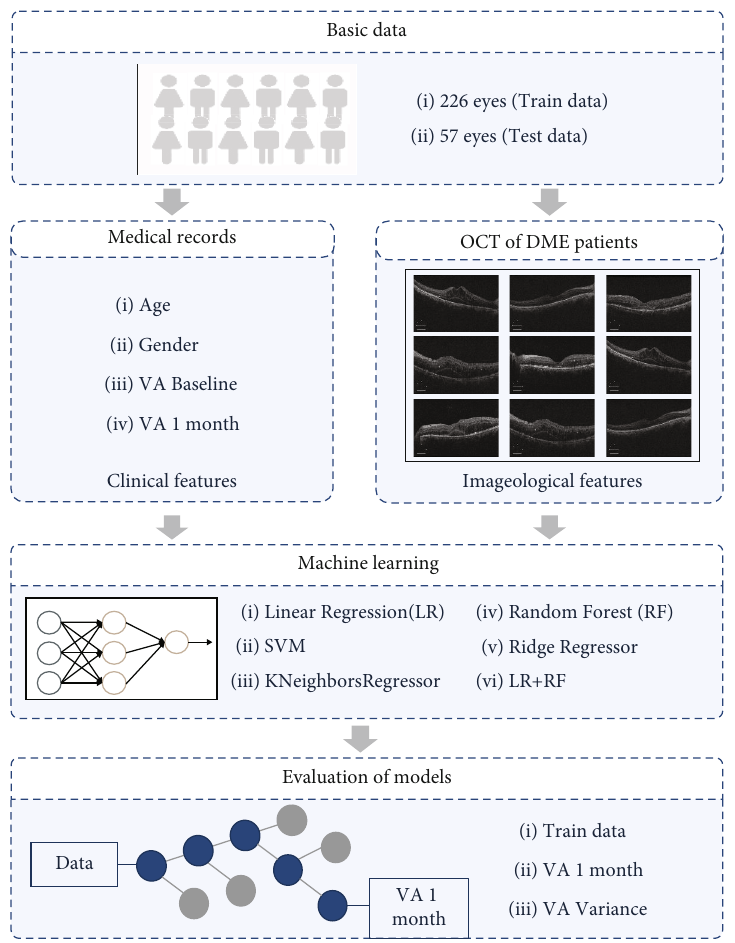
Figure 1: Overall study work fl ow. Work fl ow diagram showed the training overview for the visual acuity prediction